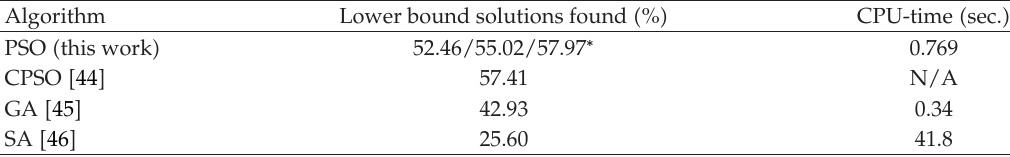
Table 15: Comparison of algorithms with respect to schedules—5000 on J30.